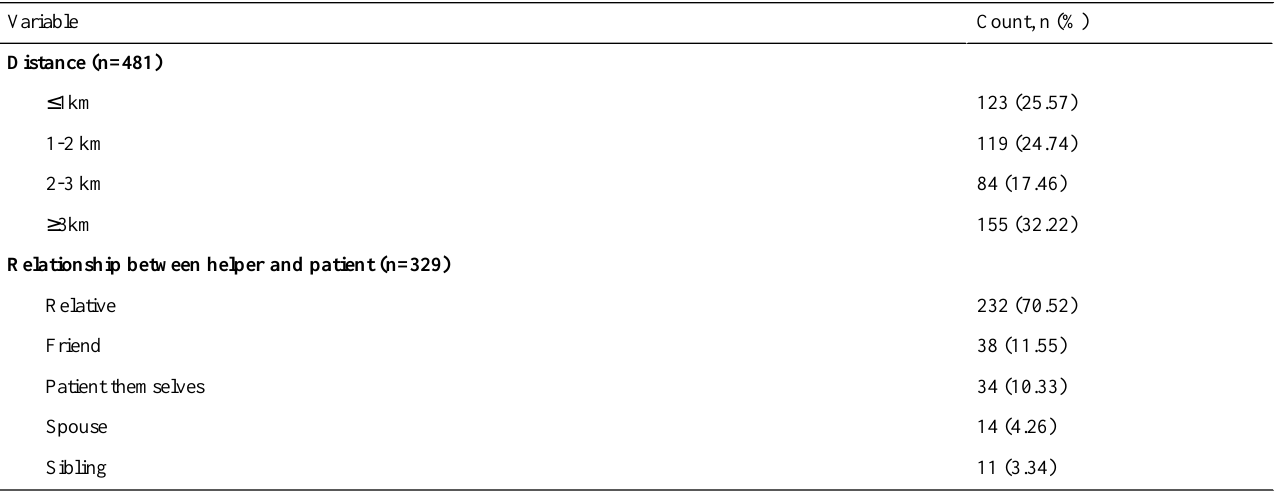
Table 2. The distance between patients and the nearest designated hospital, as well as the relationship between helpers and patients.